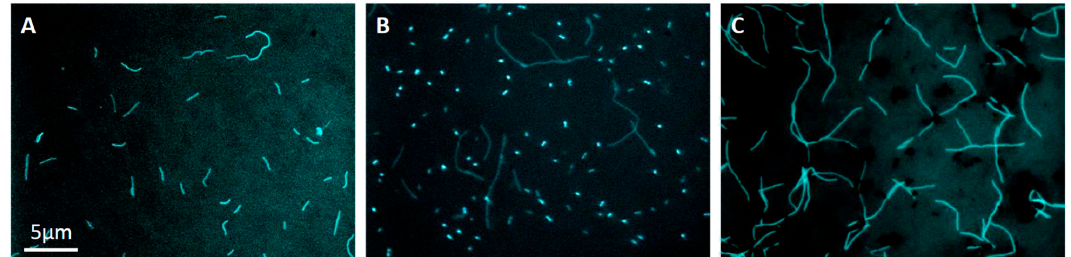
Figure 1. Fluorescent micrographs of DAPI-stained cells grown from colonies on sold media under methanogenic conditions. ( A ) Cells cultivated from a colony formed on slants containing medium 119 after methanogens were enriched under the H 2 /CO 2 gas (strain Met20-1). ( B ) Cells from a colony formed on slants containing medium 119 after methanogens were enriched under the nitrogen gas.